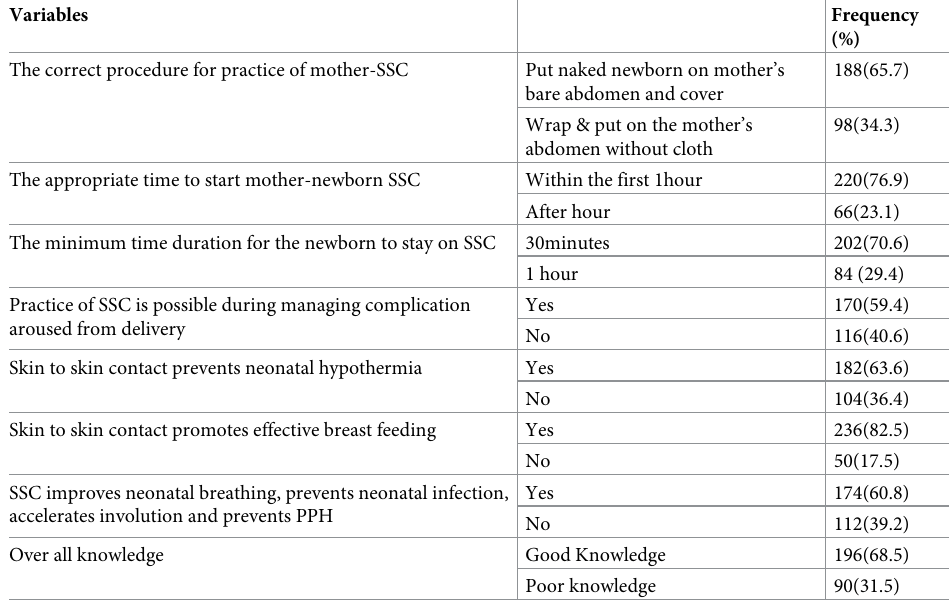
Table 2. Knowledge of health care providers on mother-newborn skin-to-skin contact of Ilu Abba Bor and Bunno Beddelle Zones health facilities, Oromia, Ethiopia